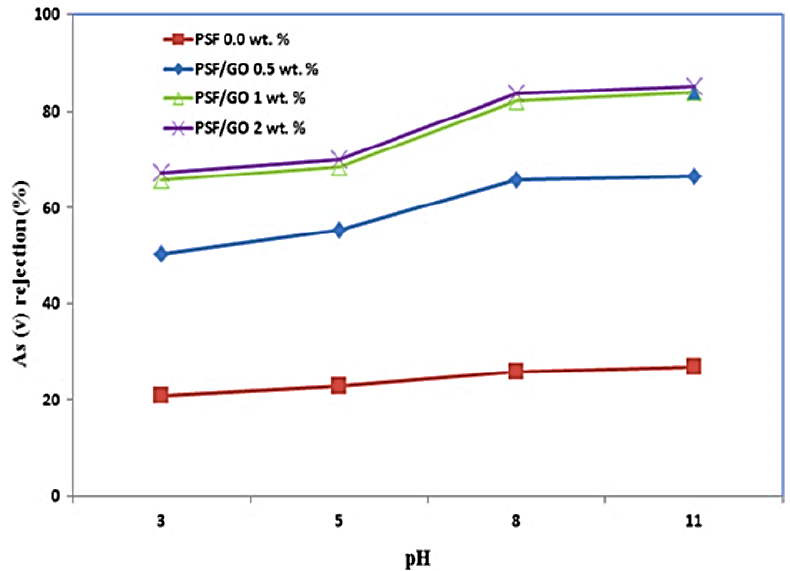
Figure 12. Percentage rejection of As (V) at different pH by prepared membranes with various GO contents (operating pressure = 4 bar; initial As (V) concentration = 300 ± 10 µ g/L; feed temperature = 25 ± 0.5 ◦ C) [139]. As—arsenate; PSF—polysulfone; PSF/GO—polysulfone/graphene oxide. Reproduced with permission from ref. [139]. Copyright 2015 Springer. Table 1. Effect of GO content on water contact angle, pure water flux, and pore structure parameters of the prepared membranes [139]. PSF — polysulfone; PSF/GO — polysulfone/graphene oxide. Reproduced with permission from reference [139]. Copyright 2015 Springer.